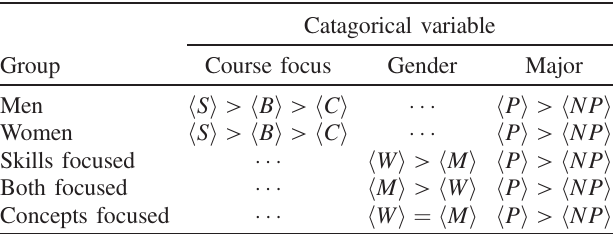
TABLE IV. Impact of each categorical variable on postinstruc- tion means as adjusted by the 3-way ANCOVAs. Adjusted means for each variable are calculated controlling for preinstruction score and the other relevant categorical variables, as described in the text. A difference between group means is indicated only when that difference was statistically significant. Here, h P i is the predicted postinstruction mean for physics students, and similarly for nonphysics students h NP i , men h M i , women h W i , skills- focused courses h S i , concepts-focused courses h C i , and both- focused courses h B i . Statistical significance of the individual comparisons between skills-focused, concepts-focused, and both- focused courses was determined using Tukey ’ s post-hoc test